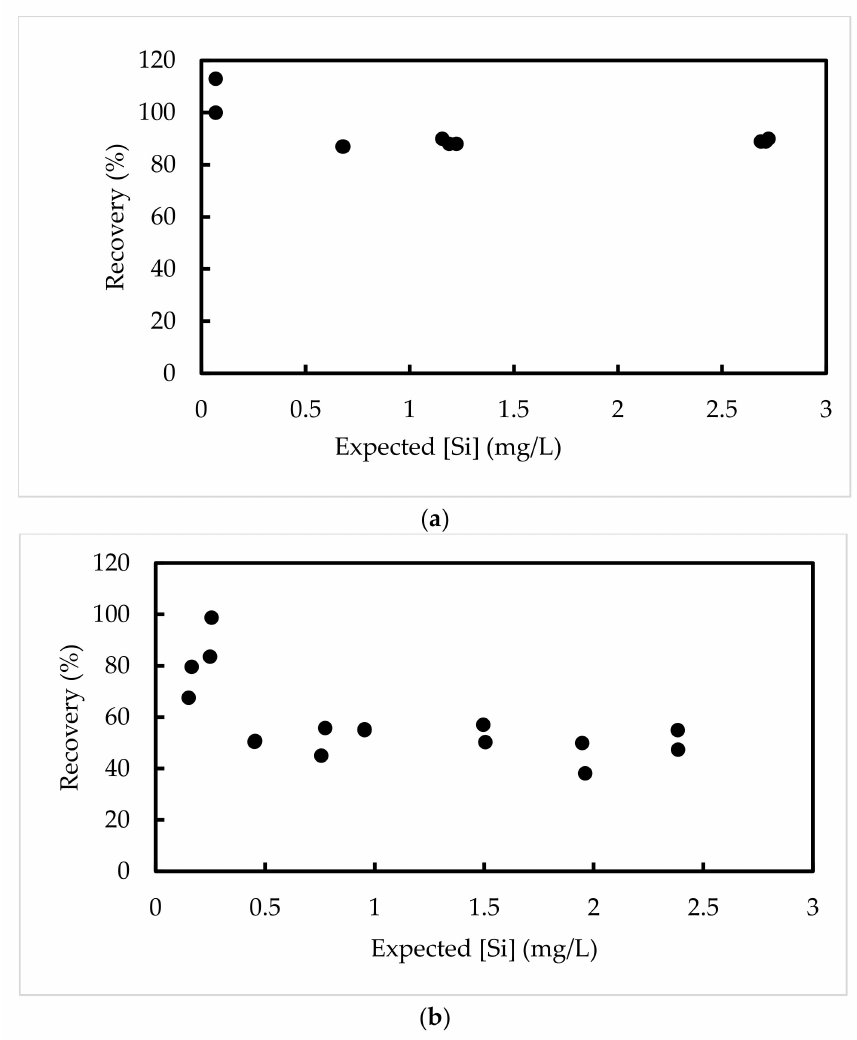
Figure 3. Recovery of Si from spiked and digested samples using either HNO 3 /H 2 O 2 or HNO 3 without H 2 O 2 . ( a ). Recovery (%) of Si with the method presented here using HNO 3 /H 2 O 2 . NPs were added to the chicken liver and digested in HNO 3 /H 2 O 2 ( n = 9). The percentage recovery in the sample was plotted against the expected raw data (Si mg/L). The results are also presented in Table 4. ( b ). Recovery of Si in the absence of H 2 O 2 . NPs were added to Wistar rat kidney and digested in 50% HNO 3 ( n = 16). The data are presented as in a. In both ( a , b ), NPs were added to attain close to 2.5 mg/L of Si as the highest concentration in the ICP